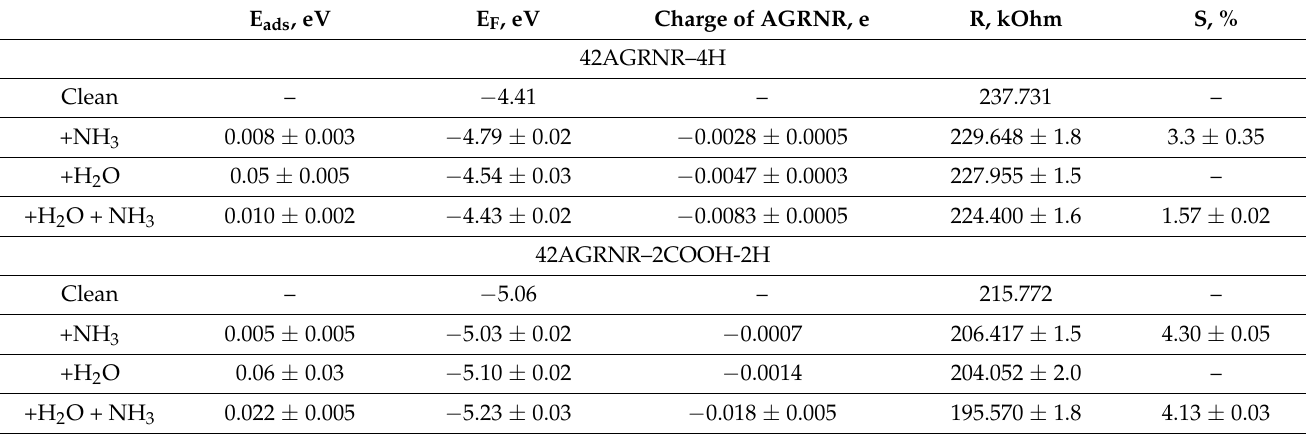
Figure 7. Atomic structure of nanoribbons and adsorption of water and ammonia: ( a ) fragment of 42AGRNR–4Hnanoribbon; ( b ) a fragment of the 42AGRNR–2COOH nanoribbon; ( c ) adsorption on a non-functionalized nanoribbon; ( d ) adsorption on a carboxylated nanoribbon (supercells of nanoribbons are shown). Table 3. Energy characteristics of non-functionalized 42AGRNR–4H zigzag nanoribbon and carboxylated 42AGRNR– 2COOH-2Нnanoribbon.